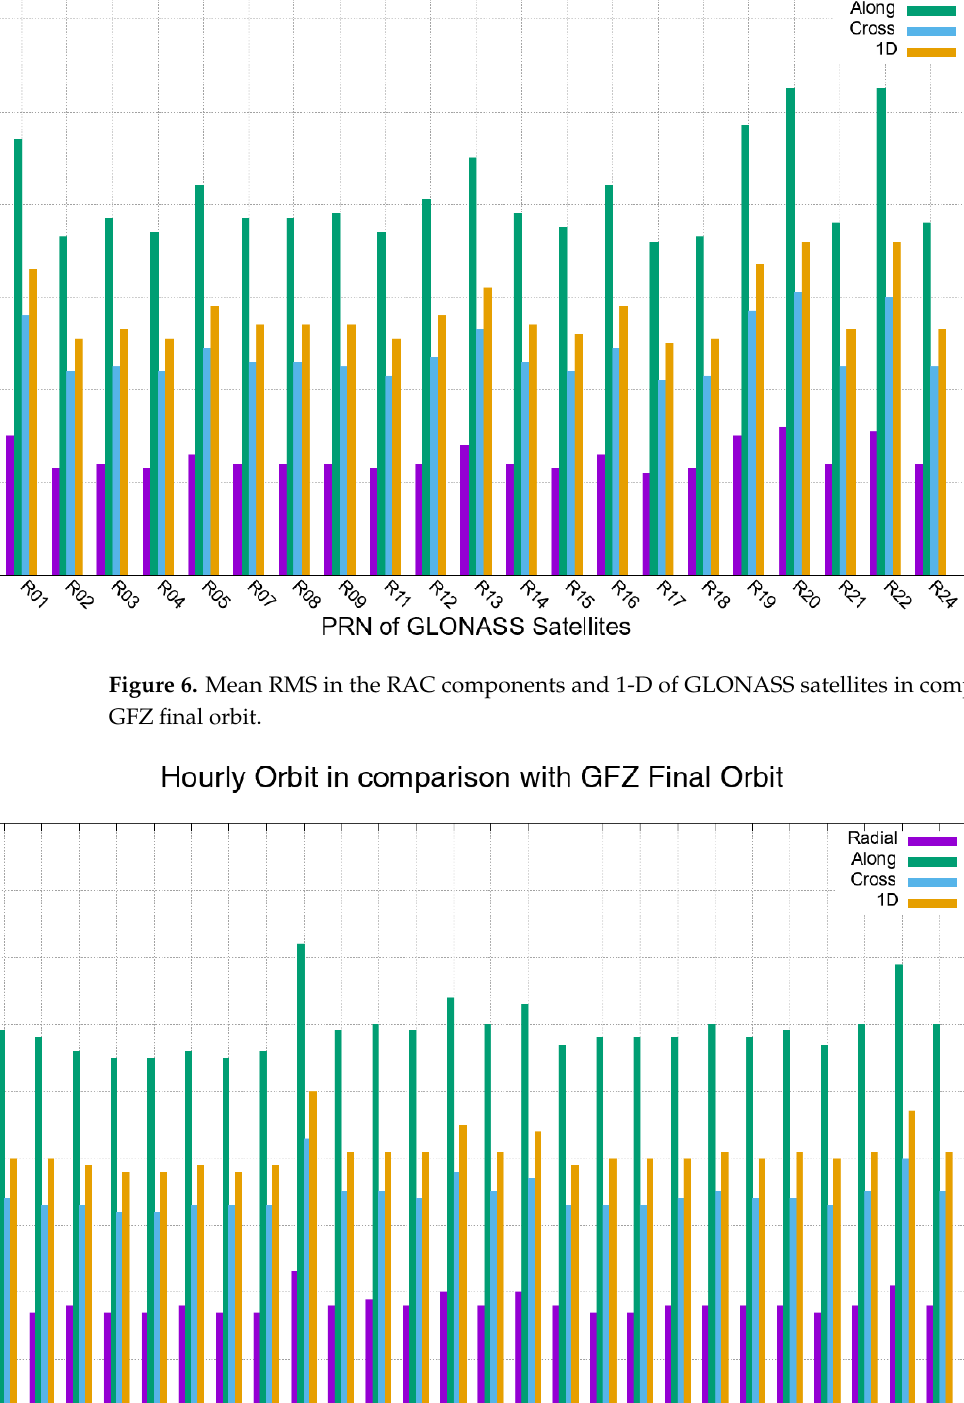
Figure 7. Mean RMS in the RAC components and 1-D of Galileo satellites in comparison with GFZ final orbit.